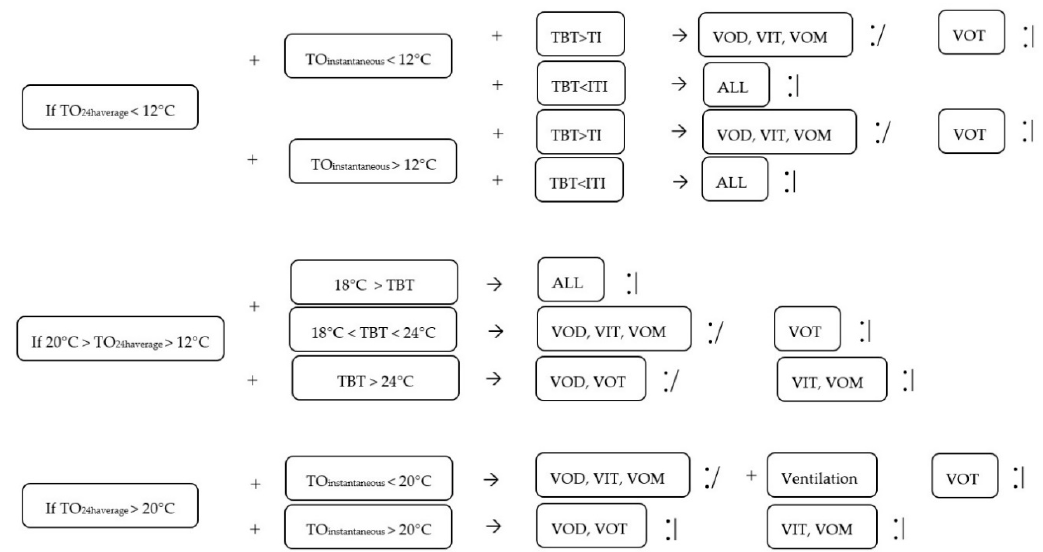
Figure 9. Control scheme for operating in automatic mode. Average Temperature Outside measured during 24 h (TO 24haverage ), Temperature Outside measured at a certain time (TO instantaneous ), Temperature Between Down (TBD), Temperature Between Top (TBT), Temperature Inside (TI), Ventilation to Outside Down (VOD), Ventilation to Inside Top (VIT), Ventilation Outside Middle (VOM), and Ventilation to Outside Top (VOT).s